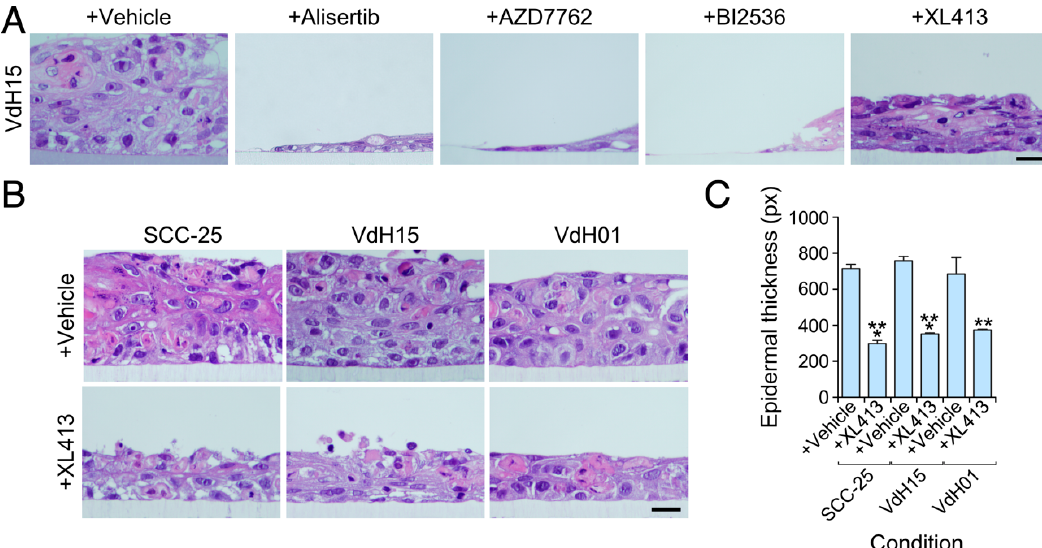
Figure 4. Cdc7 inhibitors impair the growth of head and neck cell squamous carcinoma patient-derived cells and cancer cell lines. ( A ) Representative hematoxylin-eosin tissue sections from organotypic cultures of VdH15 cells upon treatment with the indicated drugs (top). Scale bar, 10 µm ( n = 3). ( B ) Representative hematoxylin-eosin sections from organotypic cultures using the indicated cell models (top) upon treatment with the XL413 compound (left). Scale bar, 10 µm ( n = 3). ( C ) Quantification of the thickness of the epithelium according to the data obtained in panel B. **, p < 0.01; ***, p < 0.001 (Student’s t -test, n as in panel A). Data represent the mean ± SEM.